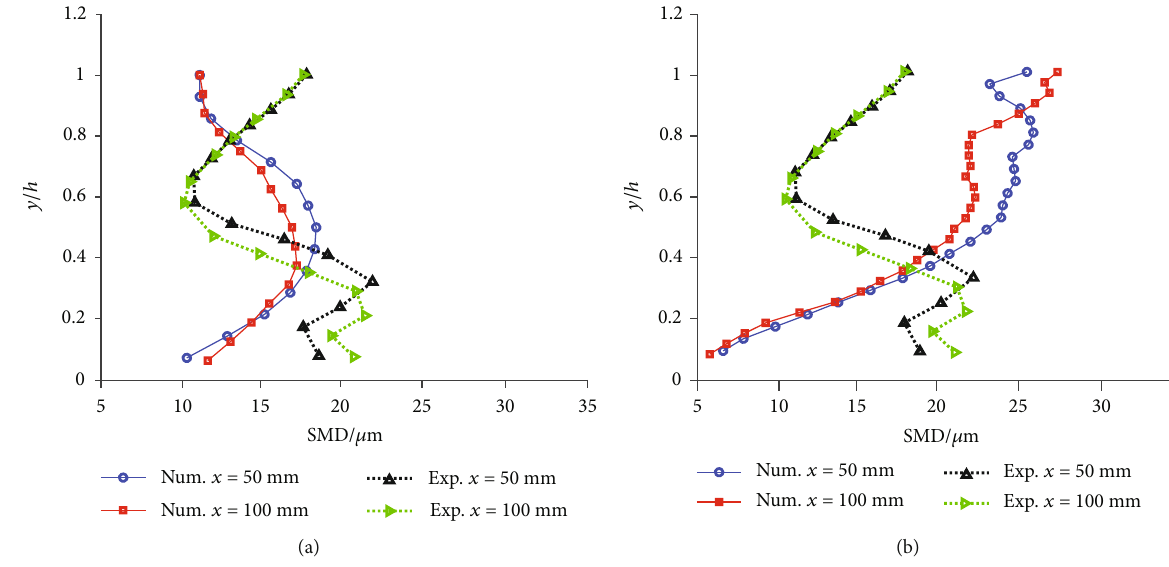
Figure 5: Downstream SMD distributions with di ff erent fl ow state: (a) turbulent and (b)